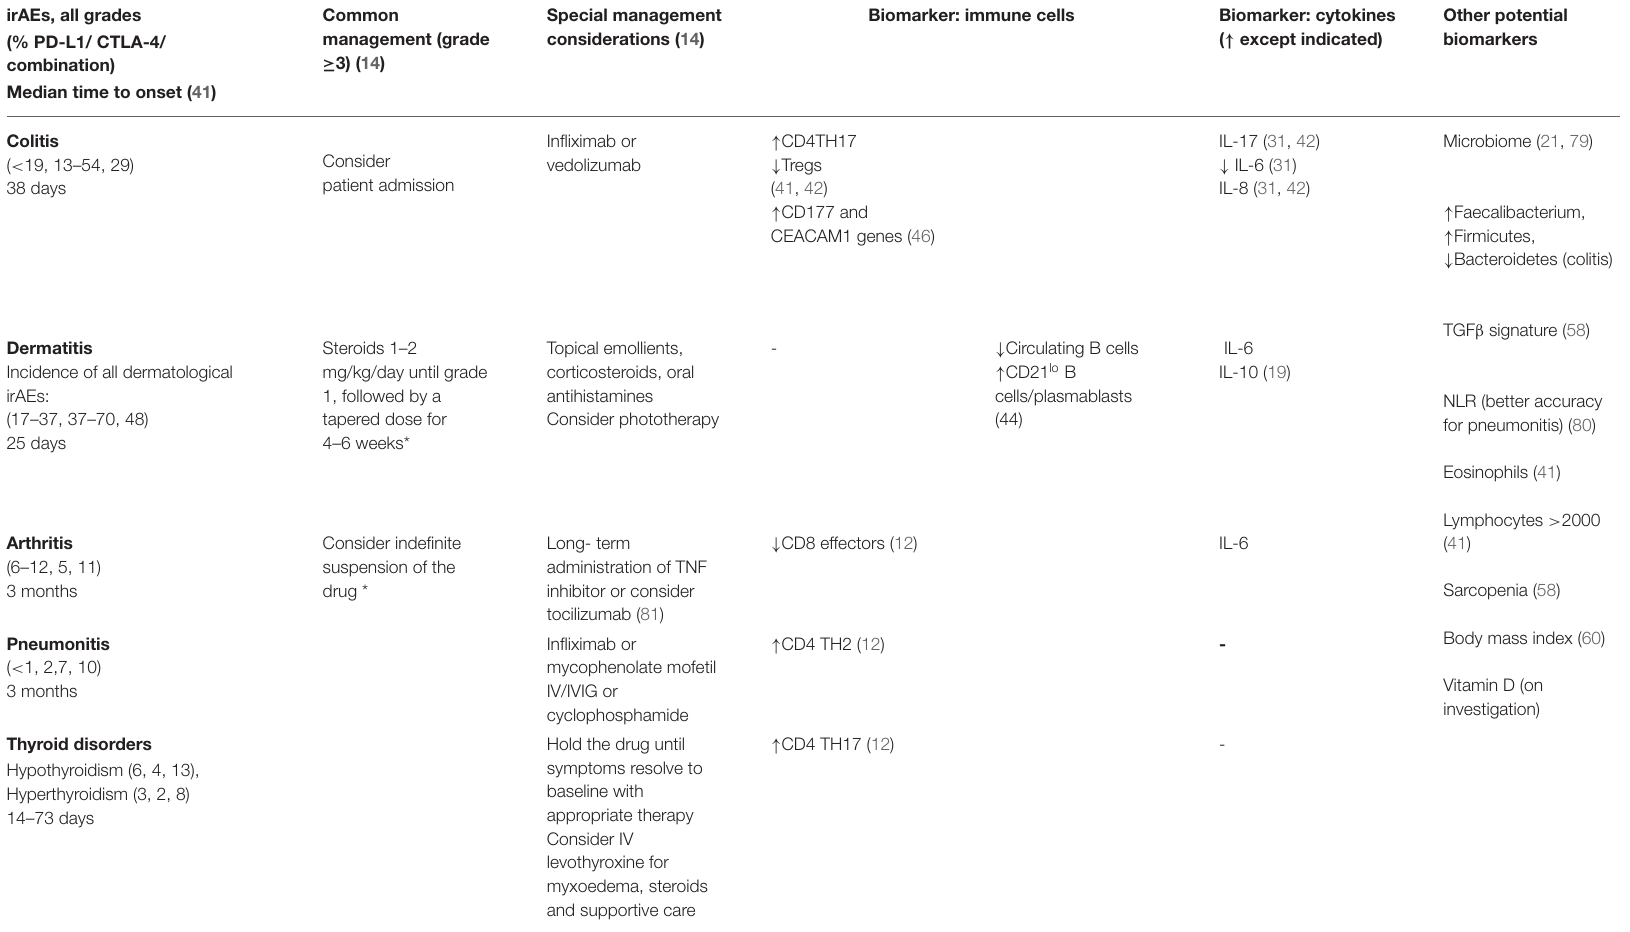
TABLE 1 | Management of the most frequent severe irAEs (14) and biomarkers that may predict them. irAEs, all